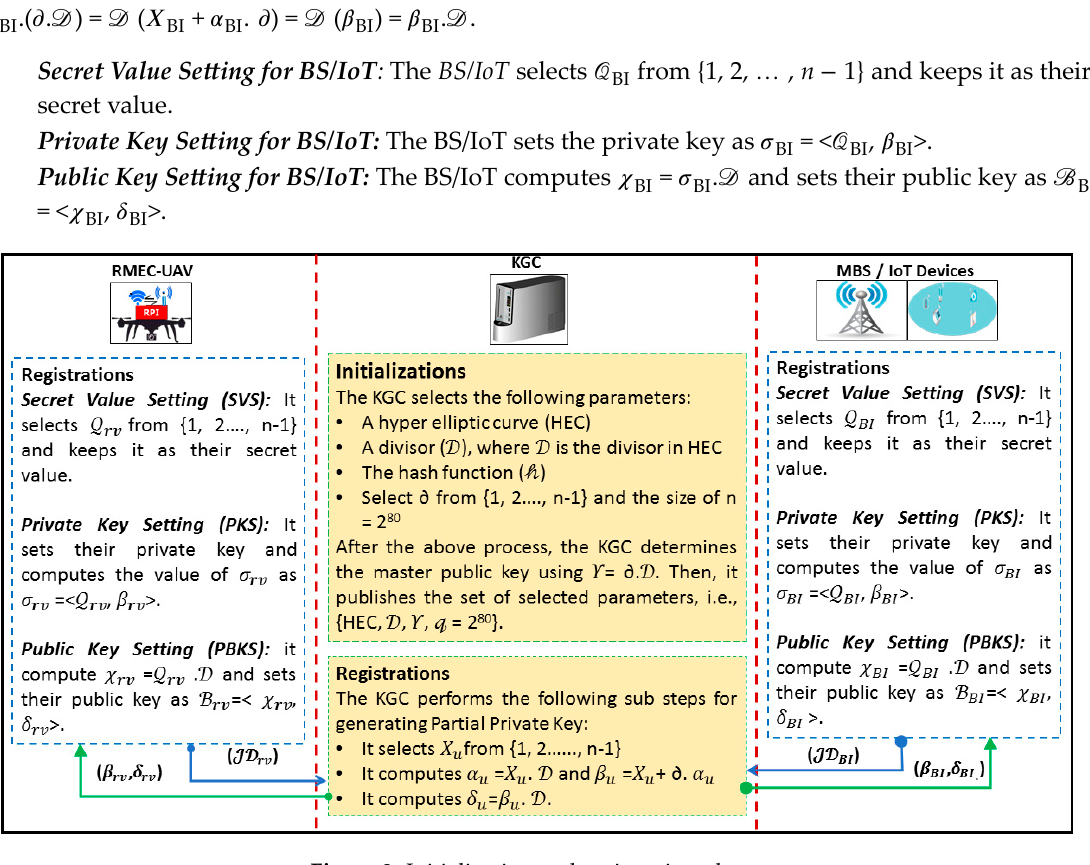
Figure 3. Initialization and registration phase.